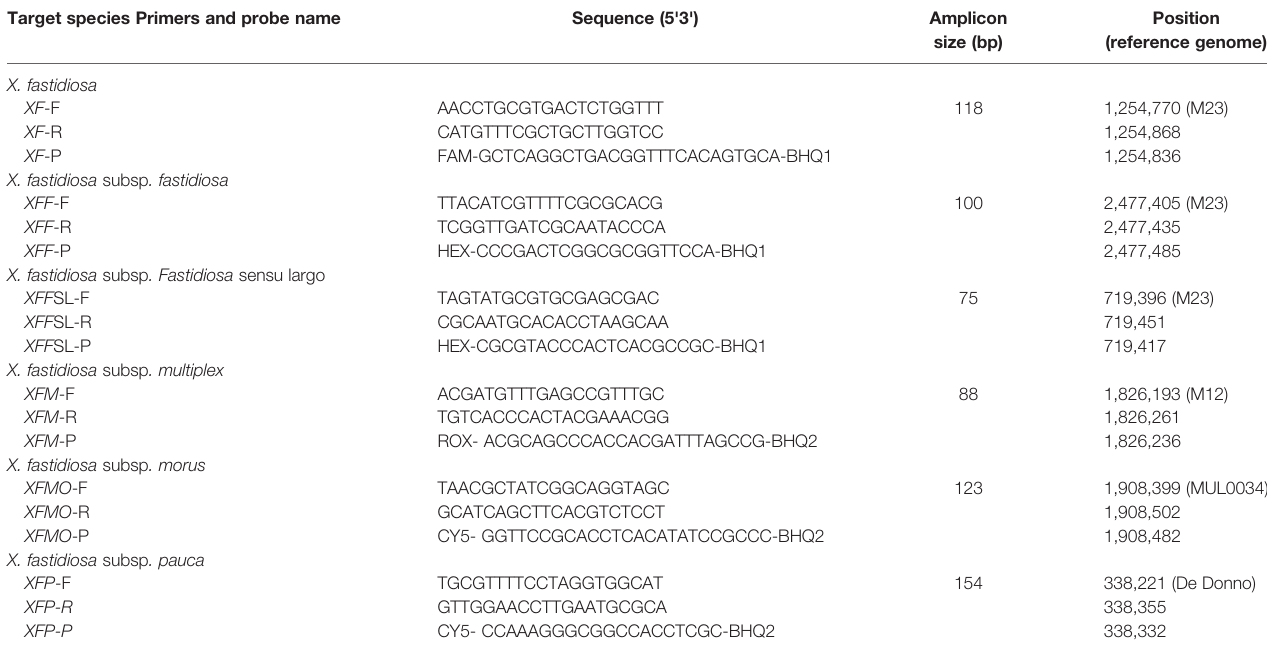
TABLE 3 | Primers and probes designed in this study for Xf detection at the species and subspecies